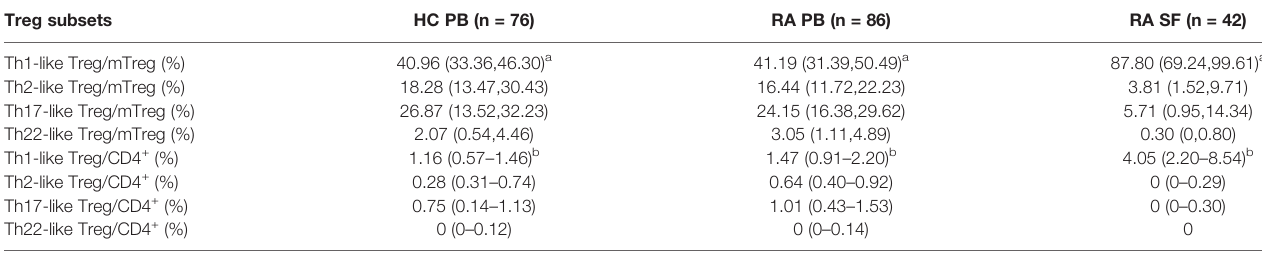
All values are given as Median (IQR). a p < 0.05 for Th1-like Treg vs. the other three Th-like Treg in mTreg (%); b p < 0.05 for Th1-like Treg vs. the other three Th-like Treg in CD4 + T cells